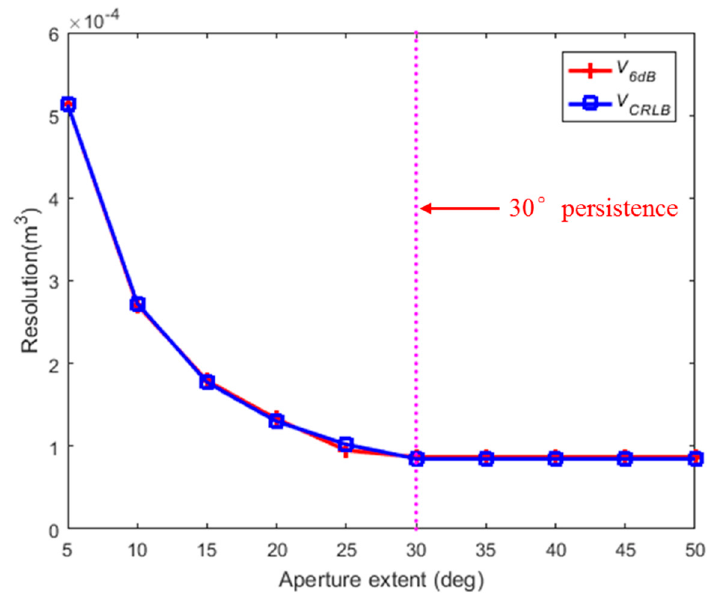
Figure 4. 3-D resolution versus azimuth aperture extent.